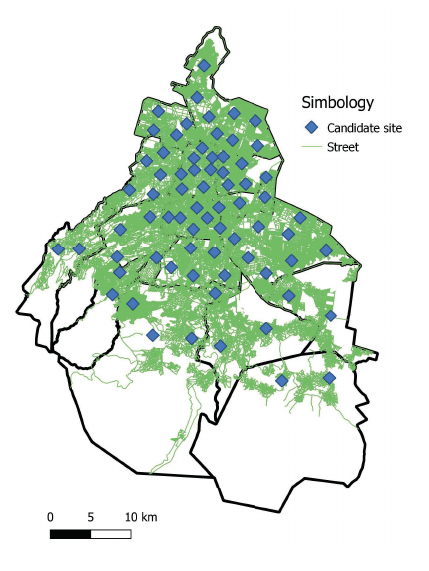
Figure 2. Modules of citizen assistance. Source: Own preparation